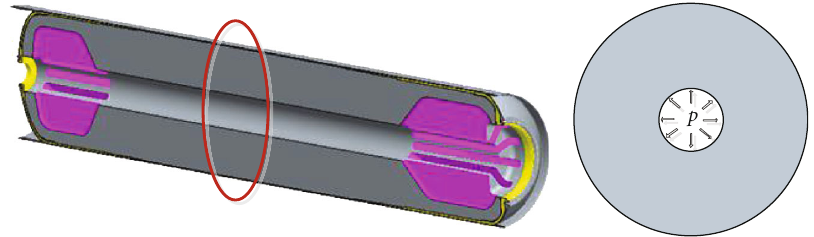
Figure 1: The scheme of the grain structure in solid rocket